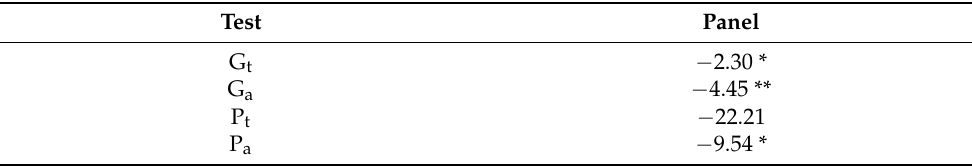
Table 3. Westerlund Cointegration Test.